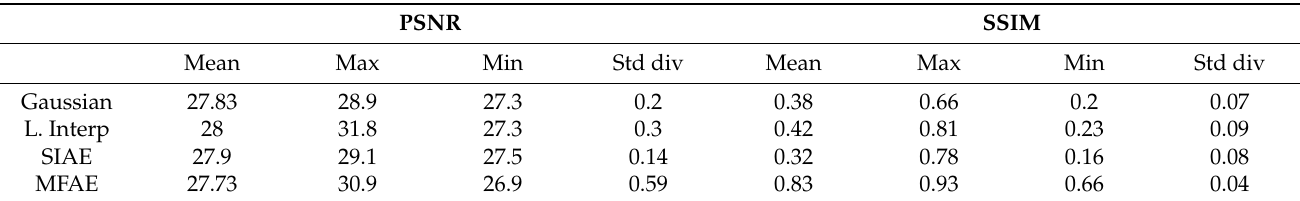
Table 1. Image quality